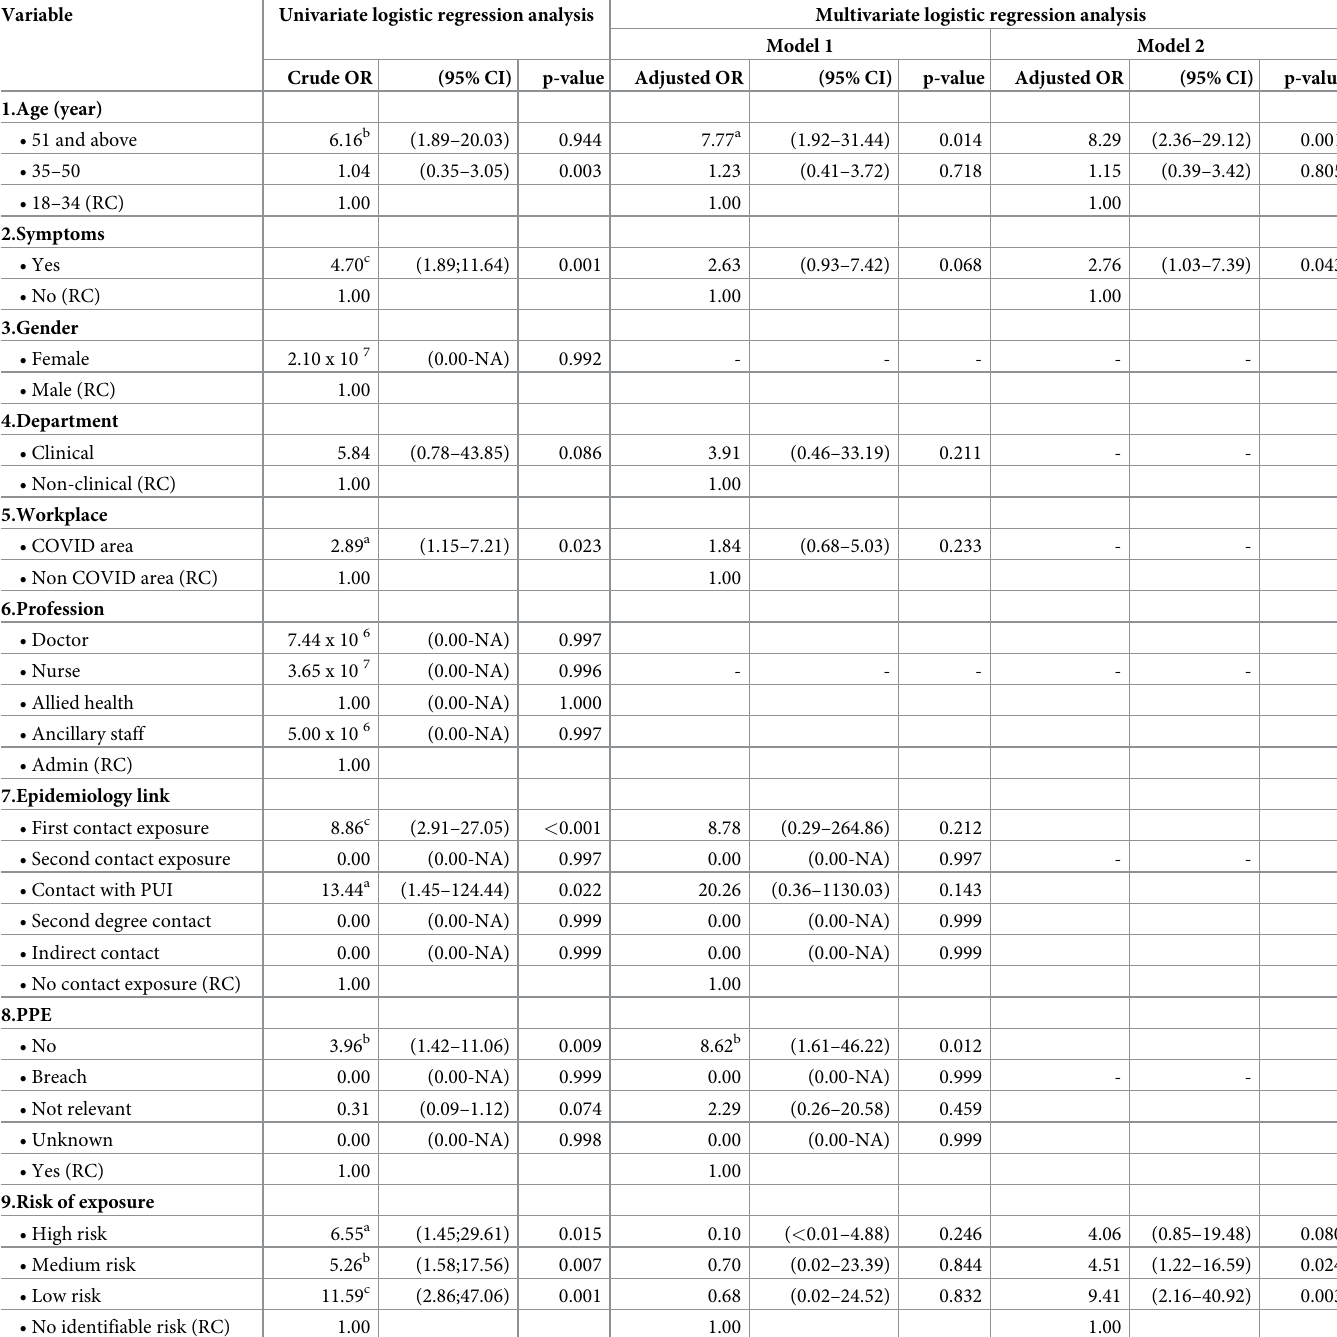
Table 2. Univariate and multivariate logistic regression analysis showing odds ratio of factors associated with COVID-19 infection among the HCWs. Variable Univariate logistic regression